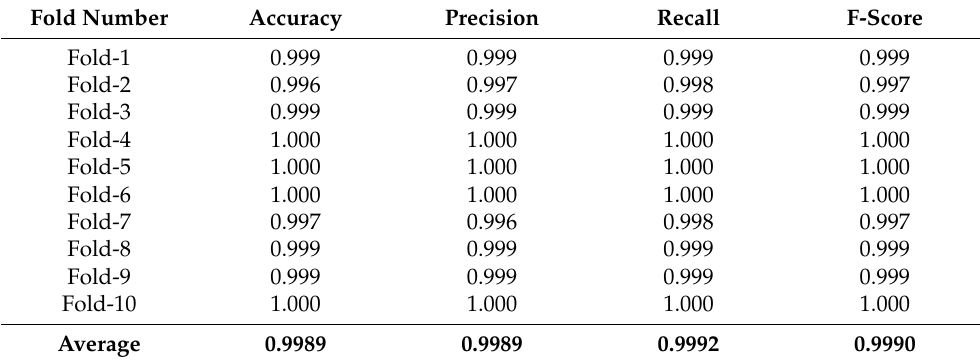
Table 6. 10-fold cross-validation results for proposed